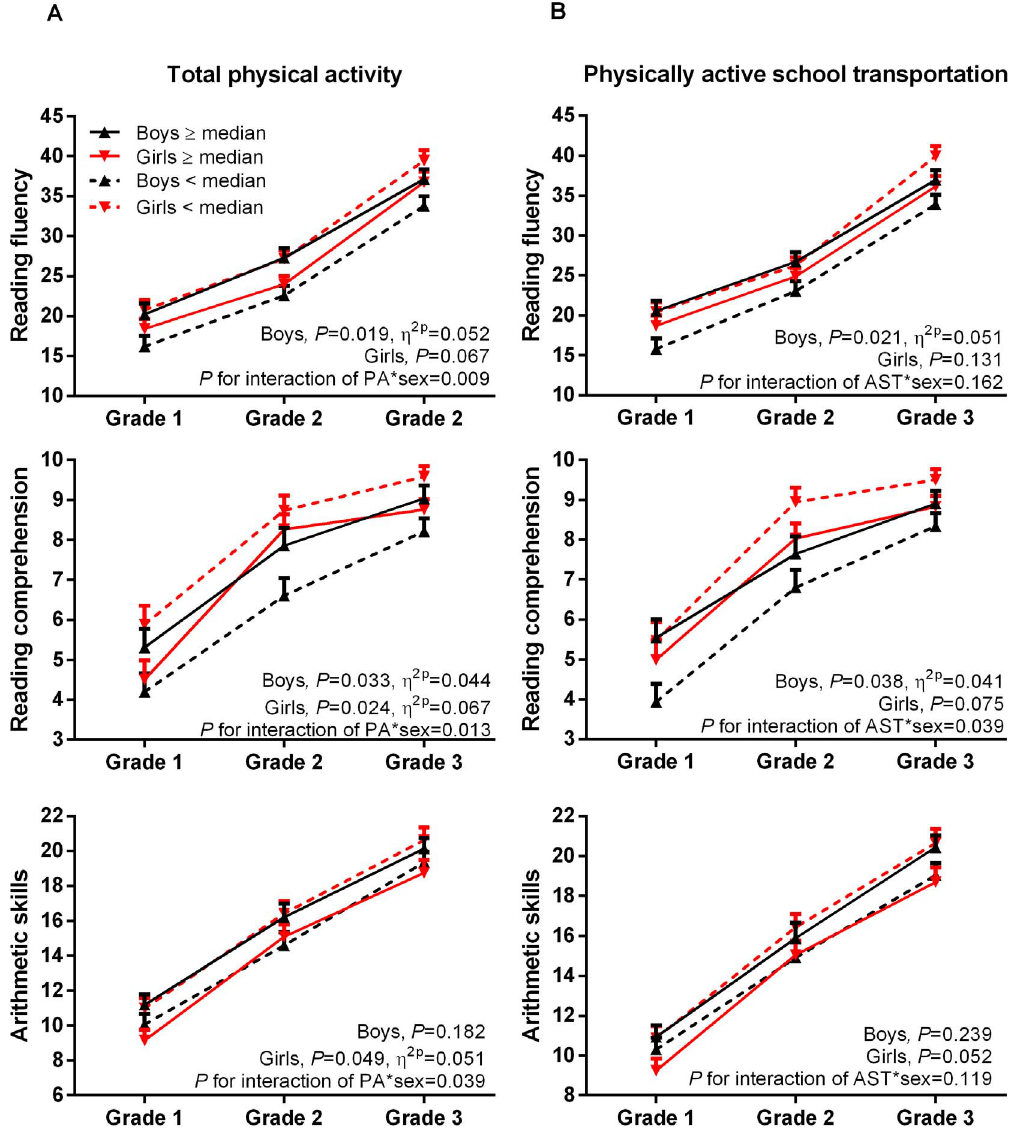
Figure 1. The differences in academic skills in Grades 1–3 between children who were in the upper and lower halves of total physical activity (A) and physically active school transportation (B) in Grade 1 among 107 boys and 79 girls. The data were adjusted for age, parental education, the PANIC study group (intervention vs. control) from the analyses of covariance with repeated measures. Error bars represent standard errors of the mean